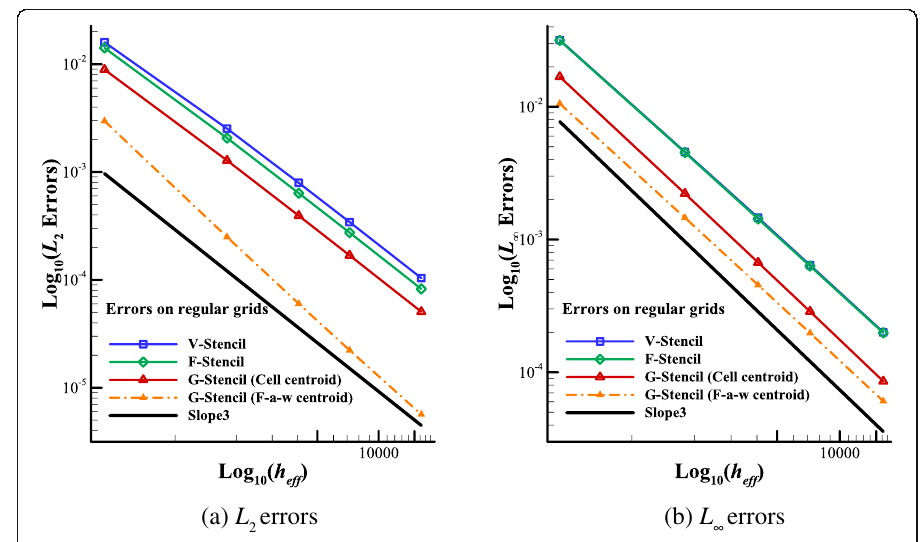
Fig. 39 ( a ) L 2 and ( b ) L ∞ errors. Errors of different stencils on regular triangular grids with AR = 10 3